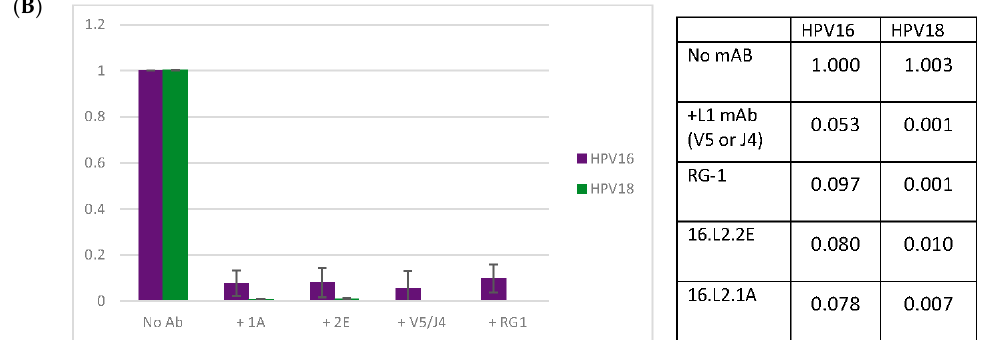
Figure 4. Anti-L2 mAbs neutralize HPV16 virus particles. Neutralizing capacity of anti-L2 mAbs was examined and mean values of three independent assays are shown. Infectivity was determined using a quantitative real-time (qRT)-PCR based assay for the detection of the E1^E4 splice transcript. ( A ) Percent QV16 post-attachment neutralization in RA2LT cells relative to infection without mAb. ( B ) Native HPV16 and HPV18 post-attachment neutralization in HaCat cells relative to infection without mAb. SEM: standard error of the mean.